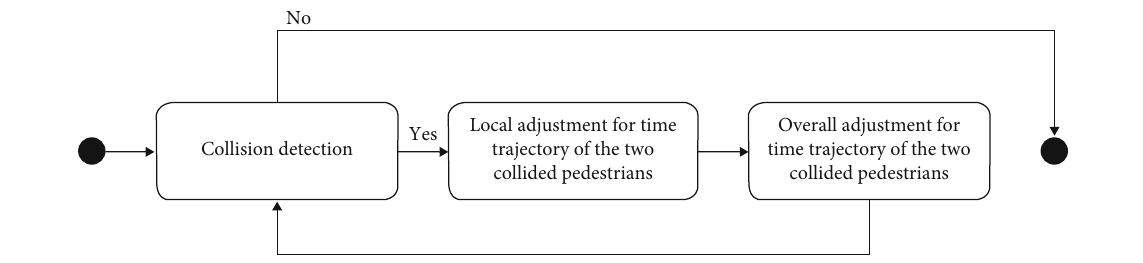
Figure 6: The collision avoidance strategy based on space track keeping.